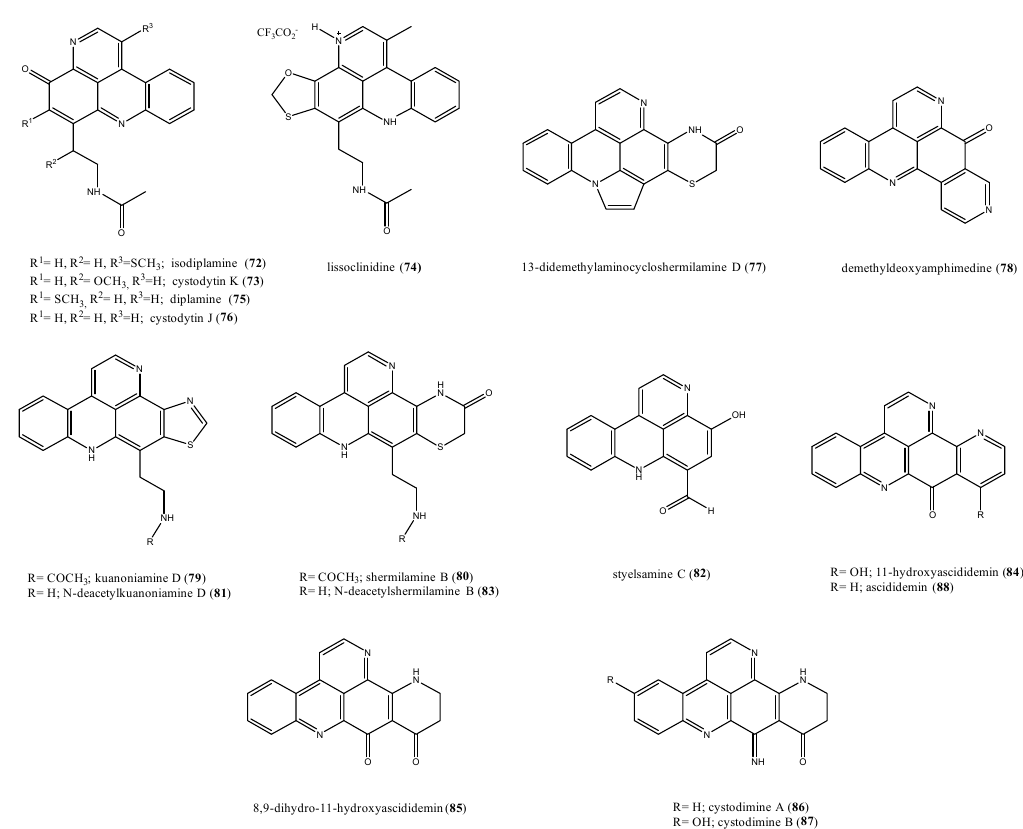
Figure 9. Structures of the pyridoacridine alkaloids 72 – 88 .